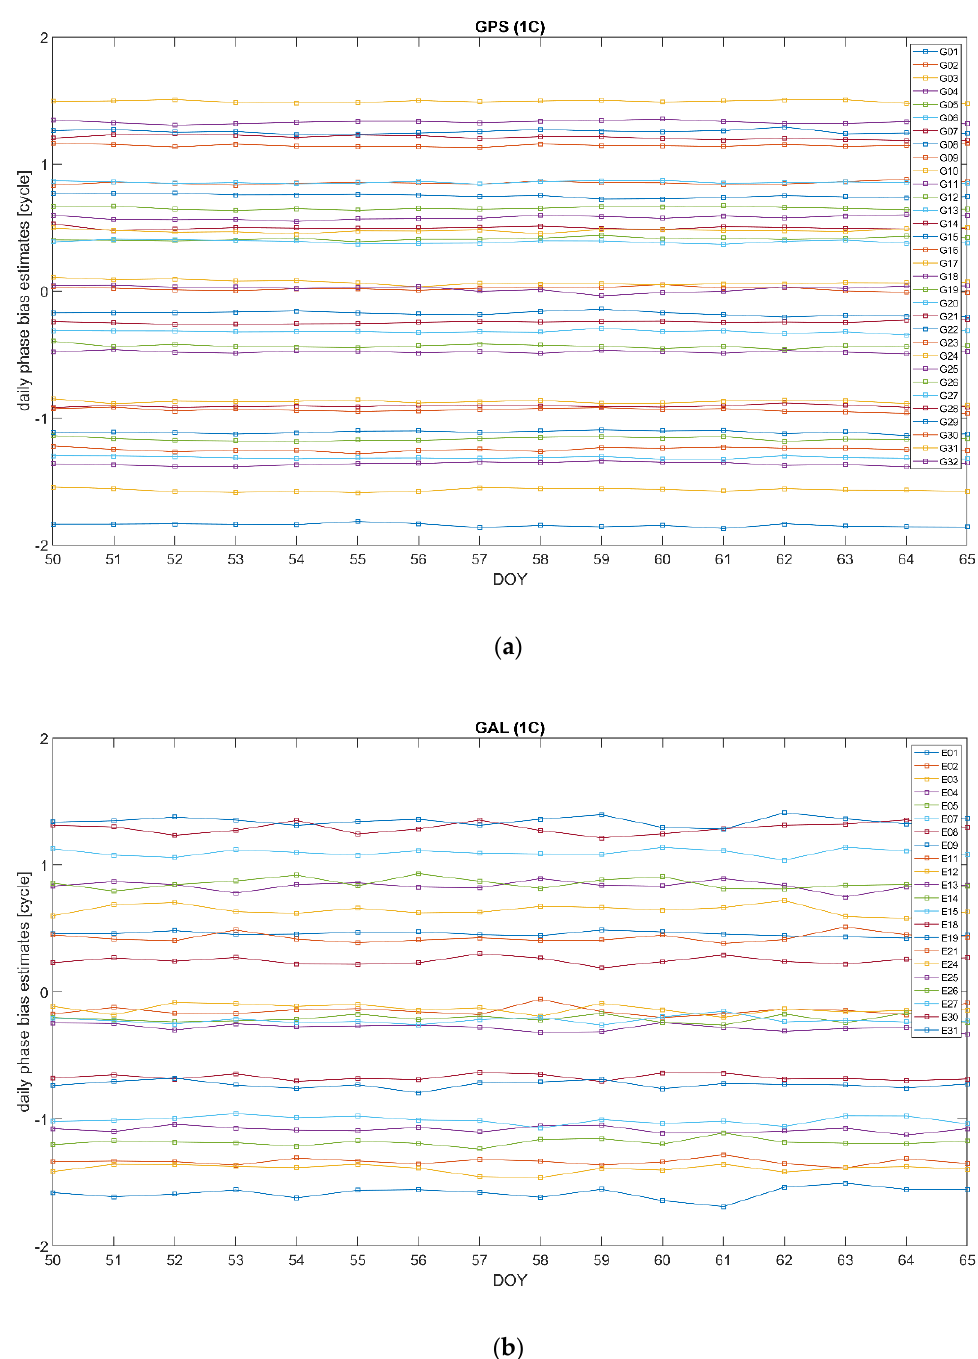
Figure 7. Daily bias ϐ MWCs estimates over a 16 − day time interval 2020/50 – 2020/65 for GPS L1 ( a ) and GALILEO E1 ( b ). The time series for individual satellites are shifted along the y-axis by PRN − 16 times 0.1. “1C” corresponds to L1 C/A for GPS and E1 pilot channel for GALILEO .